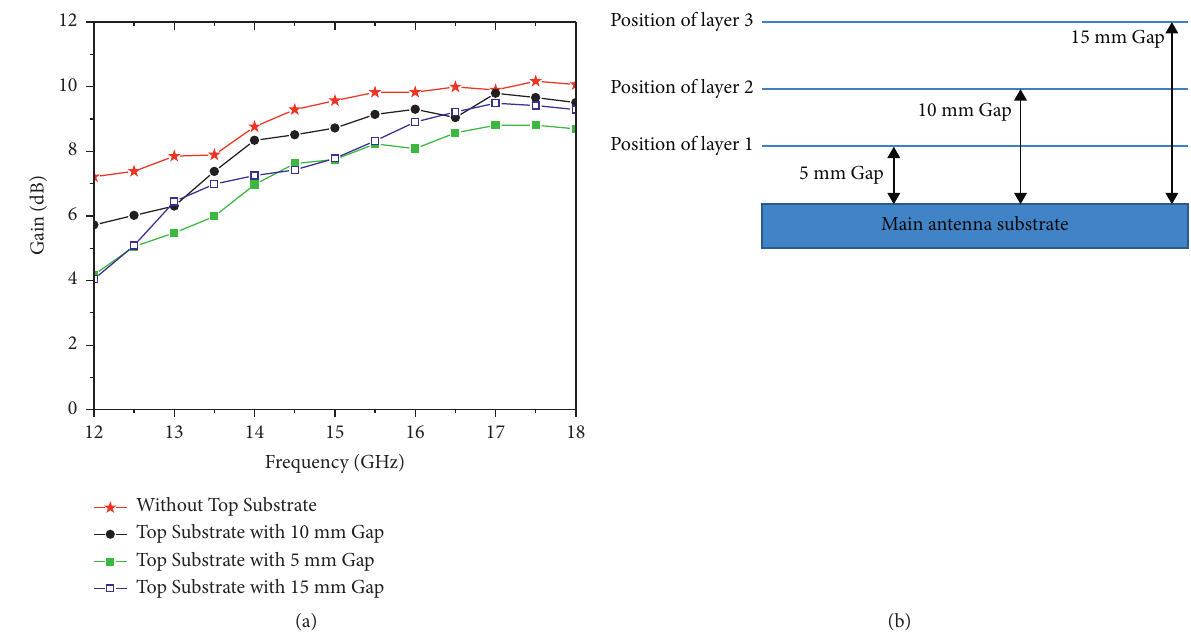
Figure 6: (a) The effect of top substrate on the antenna gain and (b) position of three substrate